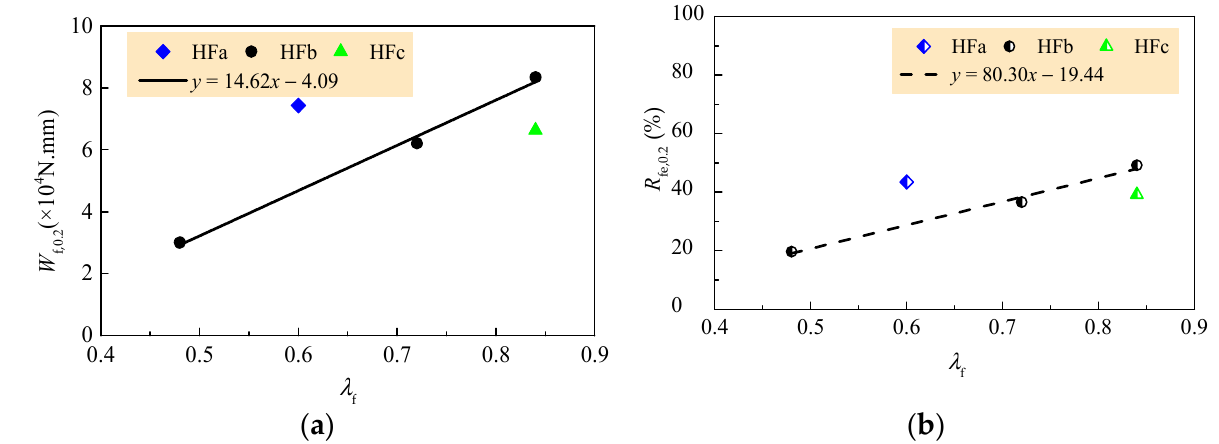
Figure 10. Axial tensile toughness changed with fiber factor: ( a ) tensile work; ( b ) toughness ratio.